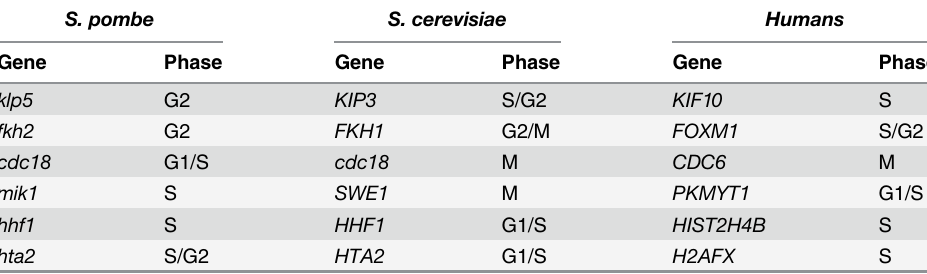
Table 3. Phases of the 6 cell-cycle genes whose circular ordered is conserved in the 3 species accord- ing to